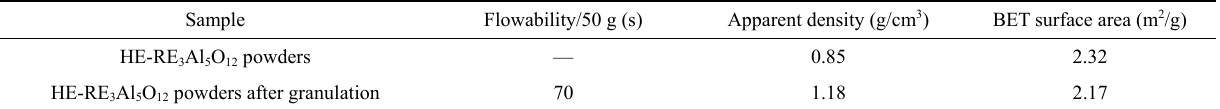
Fig. 4 (a, b) SEM images of the spray-dried HE-RE 3 Al 5 O 12 ceramic powders at different magnifications. (c) Volume fraction and (d) cumulation fraction of particle size distributions. Table 3 Physical properties of HE-RE 3 Al 5 O 12 powders